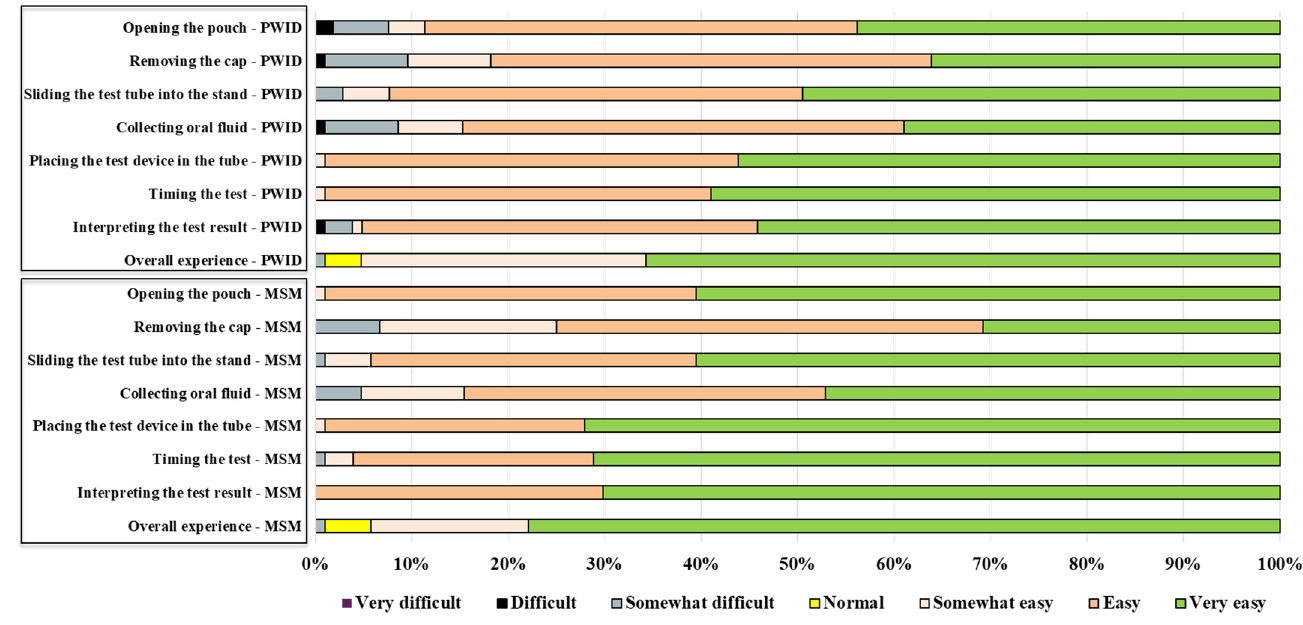
Figure 3. Participants’ perceptions of HCV self-test usability at different steps. Table 7 summarizes all the study outcomes. Acceptability was evaluated before and after self-testing. High acceptability in both groups was recorded (>90%). The majority of the participants indicated a preference to test by themselves at home for HCV infection in the future (69.5% in PWID and 76.9% in MSM, p = 0.275) and their preferred sample type was oral fluid. Usability in MSM was significantly better than that in PWID, along with higher concordance of results in MSM compared to PWID. Table 7. Summary of acceptability, preference, usability and concordance results of HCV self-testing (HCVST).